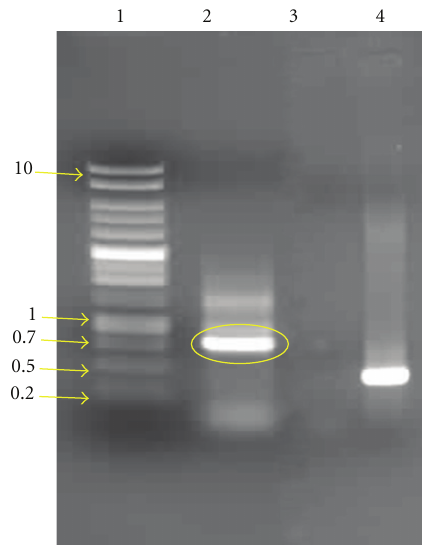
Figure 1: PCR product of the E. ocellatus serine proteases. Analysis of PCR amplification products by 0.7% agarose gel electrophoresis. Bands were visualised using the ultraviolet transillumination. Lane 2: represents the amplified PCR product (circled) of about 800 bp from E. ocellatus venom glands cDNA compared with Lane 1:1kb ladder DNA-marker bands, of known molecular weight. Lanes 3 and 4 represent a H 2 O negative control and a SOD positive control,